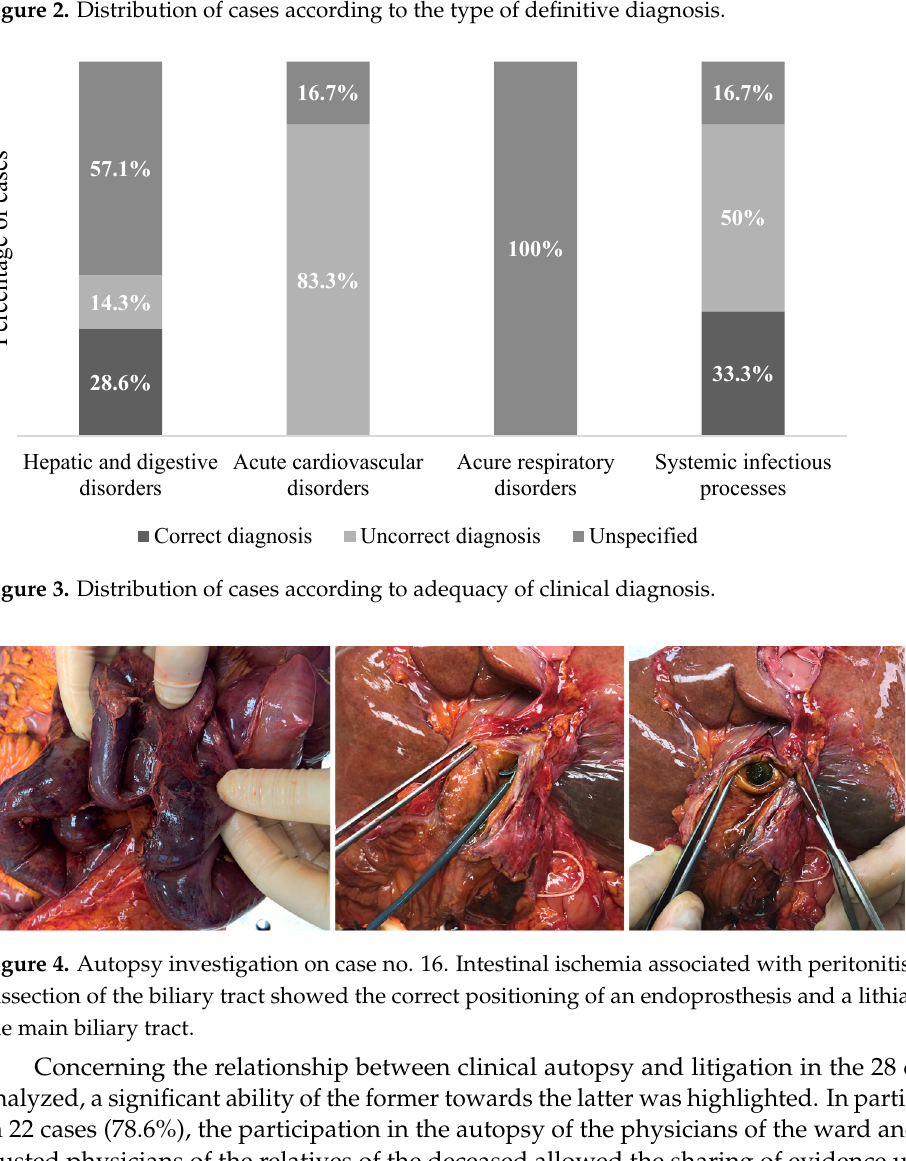
Figure 2. Distribution of cases according to the type of definitive diagnosis.